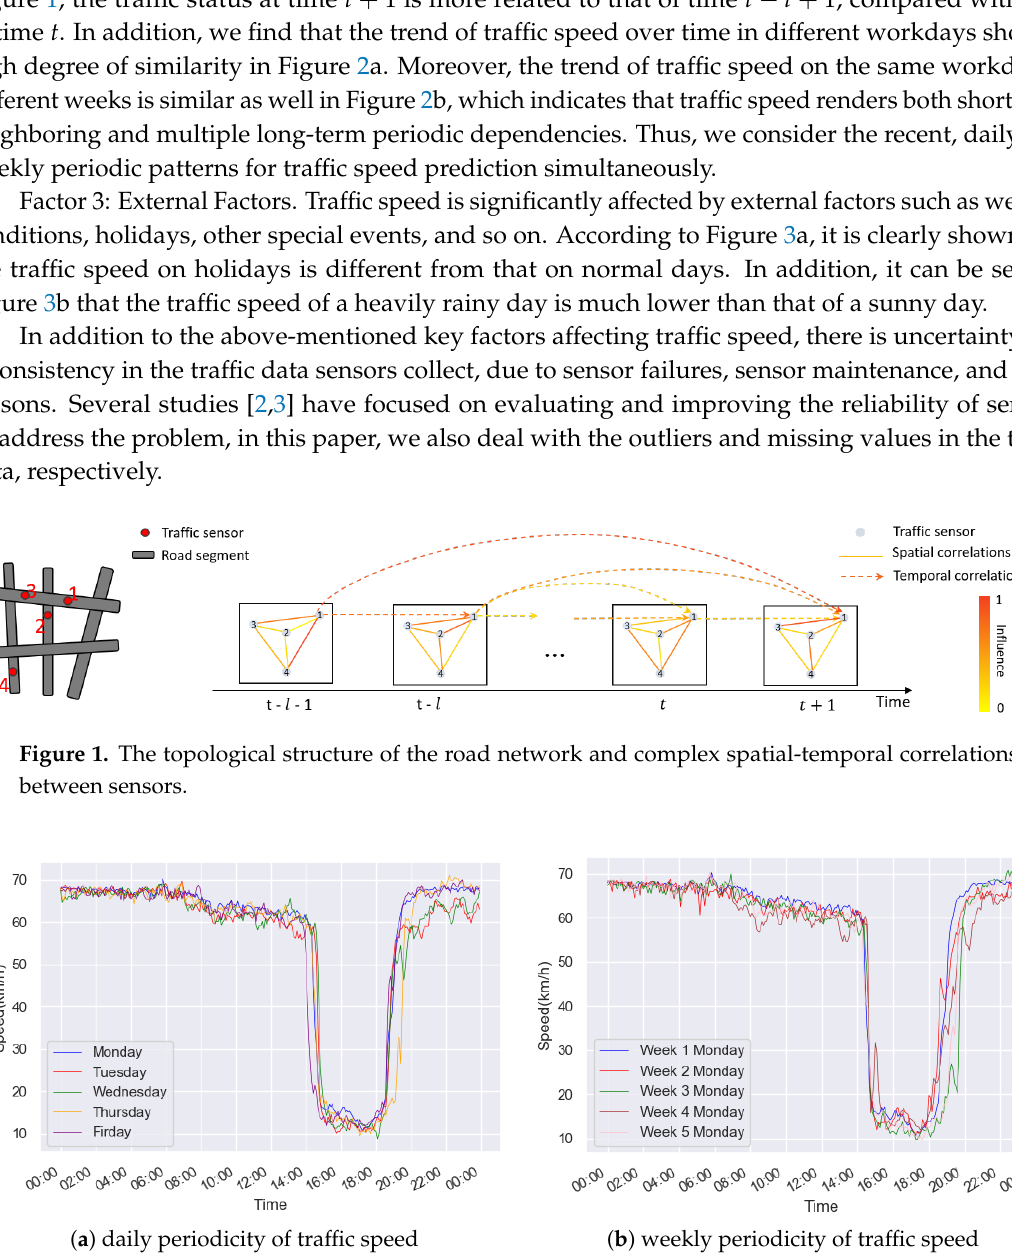
Figure 2. Multiple temporal dependencies of the traffic speed for PeMSD7. (PeMSD7 is a dataset containing traffic information from the sensors on the highways of Los Angeles